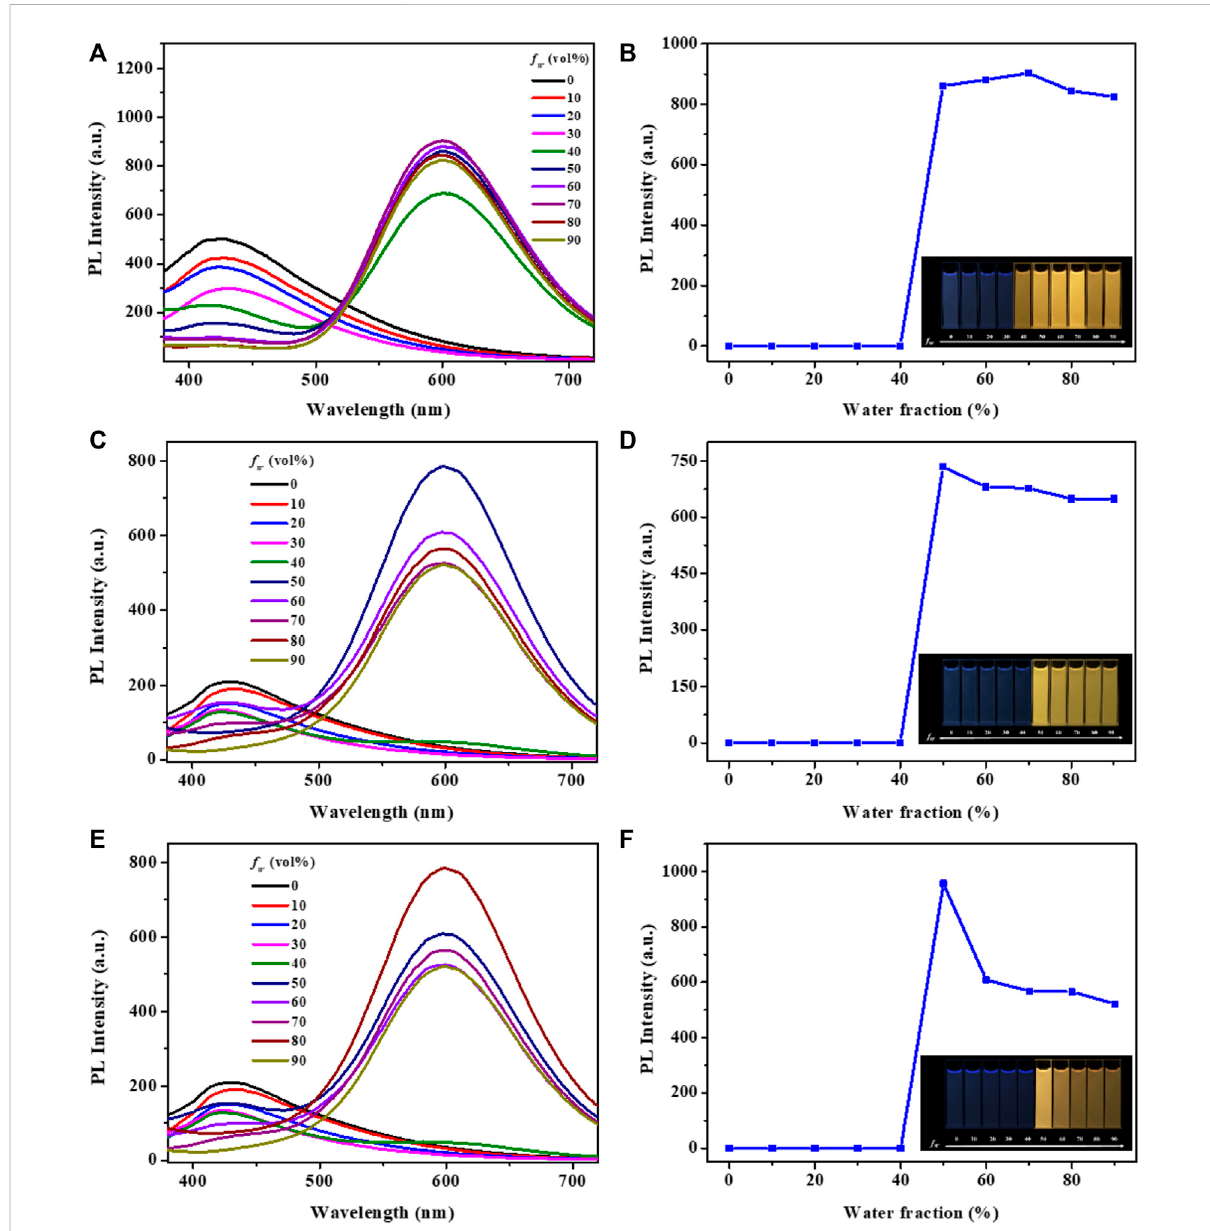
FIGURE 2 Fluorescence spectra of the complexes 1 (A) , 2 (C) , 3 (E) in DMF-H 2 O mixtures with various water fractions. Changes in emission intensity of complexes 1 (B) , 2 (D) , 3 (F) in DMF-H 2 O mixtures with various water fractions. Inset: Fluorescence imagesof complexes 1 (B) , 2 (D) , 3 (F) in